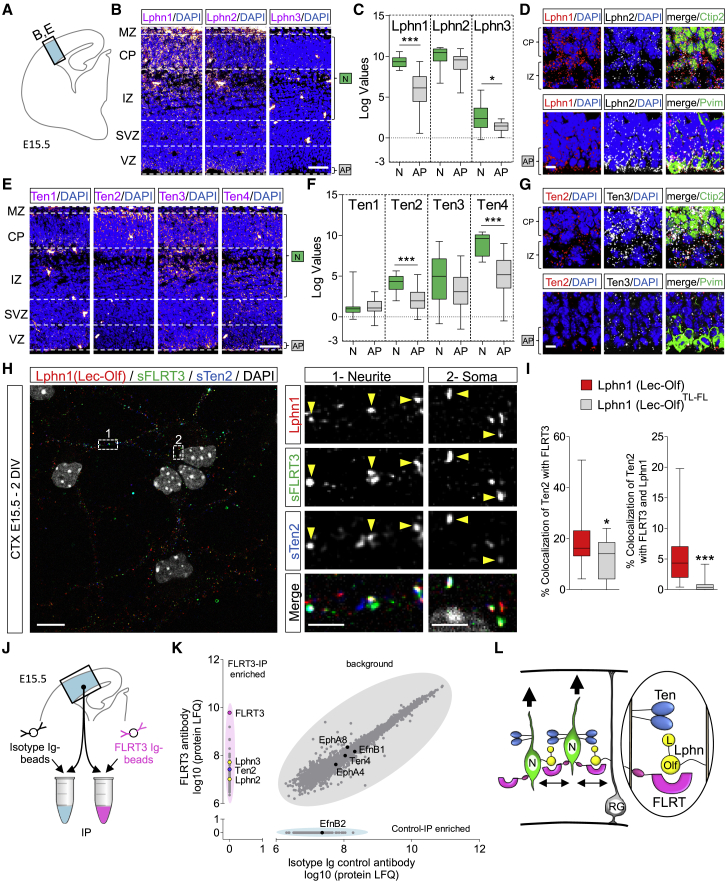
Teneurins and Latrophilins Are Expressed during Cortical Development(A) Scheme showing the location of the cortical region shown in (B) and (E).(B) In situ hybridization (ISH) for all Latrophilins (magenta) suggests that Lphn1 and Lphn2 are expressed in the cortex at E15.5. Nuclear staining with DAPI is shown in blue. The layers enriched in neurons (Ns) and apical progenitors (AP) are indicated.(C) Lphn1-3 expression in neurons and APs was quantified using published single-cell RNA profiling data (Kawaguchi et al., 2008; GEO: GSE10881). n = 15–20; ∗p < 0.05, ∗∗∗p < 0.001, two-tailed Student’s t test. The data are presented as whisker plots.(D) Double ISH for Lphn1 (red) and Lphn2 (white) combined with immunostaining for Pvim (green) or Ctip2 (green). The AP layer where radial glial (RG) cells are located, the cortical plate (CP), and the intermediate zone (IZ) are indicated.(E) ISH for Teneurins (magenta) reveals expression in neurons. Nuclear staining with DAPI is shown in blue.(F) Ten1-4 expression in neurons and APs was quantified using published data (Kawaguchi et al., 2008; GEO: GSE10881). n = 15–20; ∗∗∗p < 0.001, two-tailed Student’s t test. The data are presented as whisker plots.(G) Double ISH for Ten2 (red) and Ten3 (white) combined with immunostaining for the neuronal marker Ctip2 (green) and RG cell marker Pvim (green). The locations of the AP layer, CP, and IZ are indicated.(H) Surface staining for FLRT3 (red) and Ten2 (green) on E15.5 cortical neurons after 2 days in vitro (DIV), treated with Lphn1 (Lec-Olf) protein, shows that FLRT3 and Ten2 are expressed in both neurite (dashed rectangle labeled as 1) and soma compartments (dashed rectangle labeled as 2) and found in proximity to Lphn1 protein (high-magnification images on the right). For examples of super-resolution images, see Figure S3M.(I) Proximal Ten2 and FLRT3 staining was quantified for samples incubated with Lphn wild-type (H) or FL-TL mutant (Figure S3K) protein (graph on the left). We also quantified proximal staining for all three proteins (graph on the right). n > 30 fields from 3 experiments. ∗p < 0.001, ∗∗∗p < 0.001, two-tailed Student’s t test.(J) Scheme showing the location of the cortical region used for pull-down with control or FLRT3 antibodies.(K) Scatterplot results showing the clusters of proteins captured by control and FLRT3 antibody and revealed by mass spectrometry using label-free quantification (LFQ) quantitation. A pink ellipse delineates proteins enriched in FLRT3 pull-down. A blue ellipse indicates proteins enriched by control antibody. A gray ellipse shows proteins similarly enriched under both conditions. The results of two separate sets of pull-downs were averaged. Western blot results are shown in Figures S3P and S3Q.(L) A model showing that migrating neurons expressing Lphns, FLRTs, and Teneurins could interact in trans with Latrophilins located on radial glial fibers or neurons. The Lec and Olf domains of Latrophilins are indicated.Scale bars represent 150 μm (B and E), 15 μm (D, G, and H), and 2 μm (inset in H).